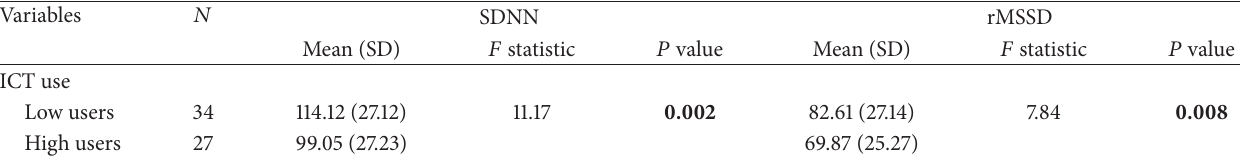
Table 3: Means of SDNN (ms) and rMSSD (ms) by ICT use, adjusted for gender, age and BMI.